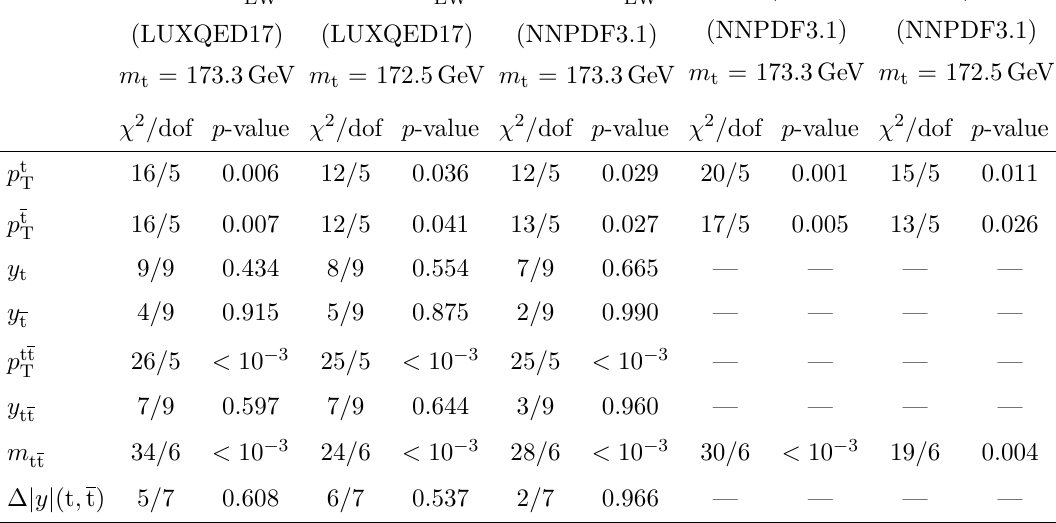
Table 49 . The (cid:31) 2 /dof and p -values quantifying the agreement between the (cid:12)ve theoretical predic- tions with NNLO+ (cid:11) 3 and NNLO+NNLL 0 precision and the measured, parton-level normalised EW cross sections are shown.